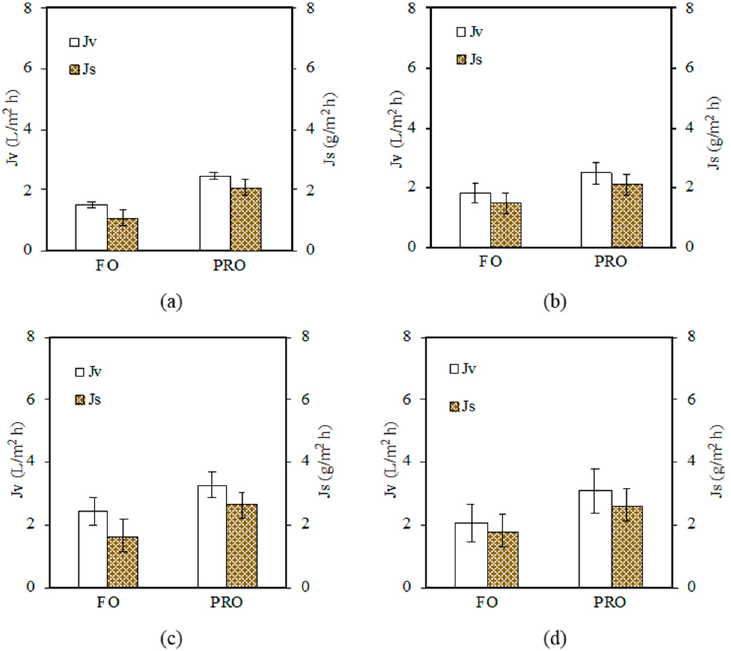
Figure 9. Water flux ( J v ) and reverse solute flux ( J s ) of TFC NF membranes under FO and PRO mode: ( a ) TFC NF (control), ( b ) PDA/GO0.3, ( c ) PDA/GO0.5, and ( d ) PDA/GO0.7 (Operation mode: engineered osmosis; feed solution: pure water; draw solution: 4 M MgCl 2 ; cross flow velocity: 0.3272 m/s for both feed and draw solution; operation period: 2 h; temperature: 24 ◦ C (+1)).